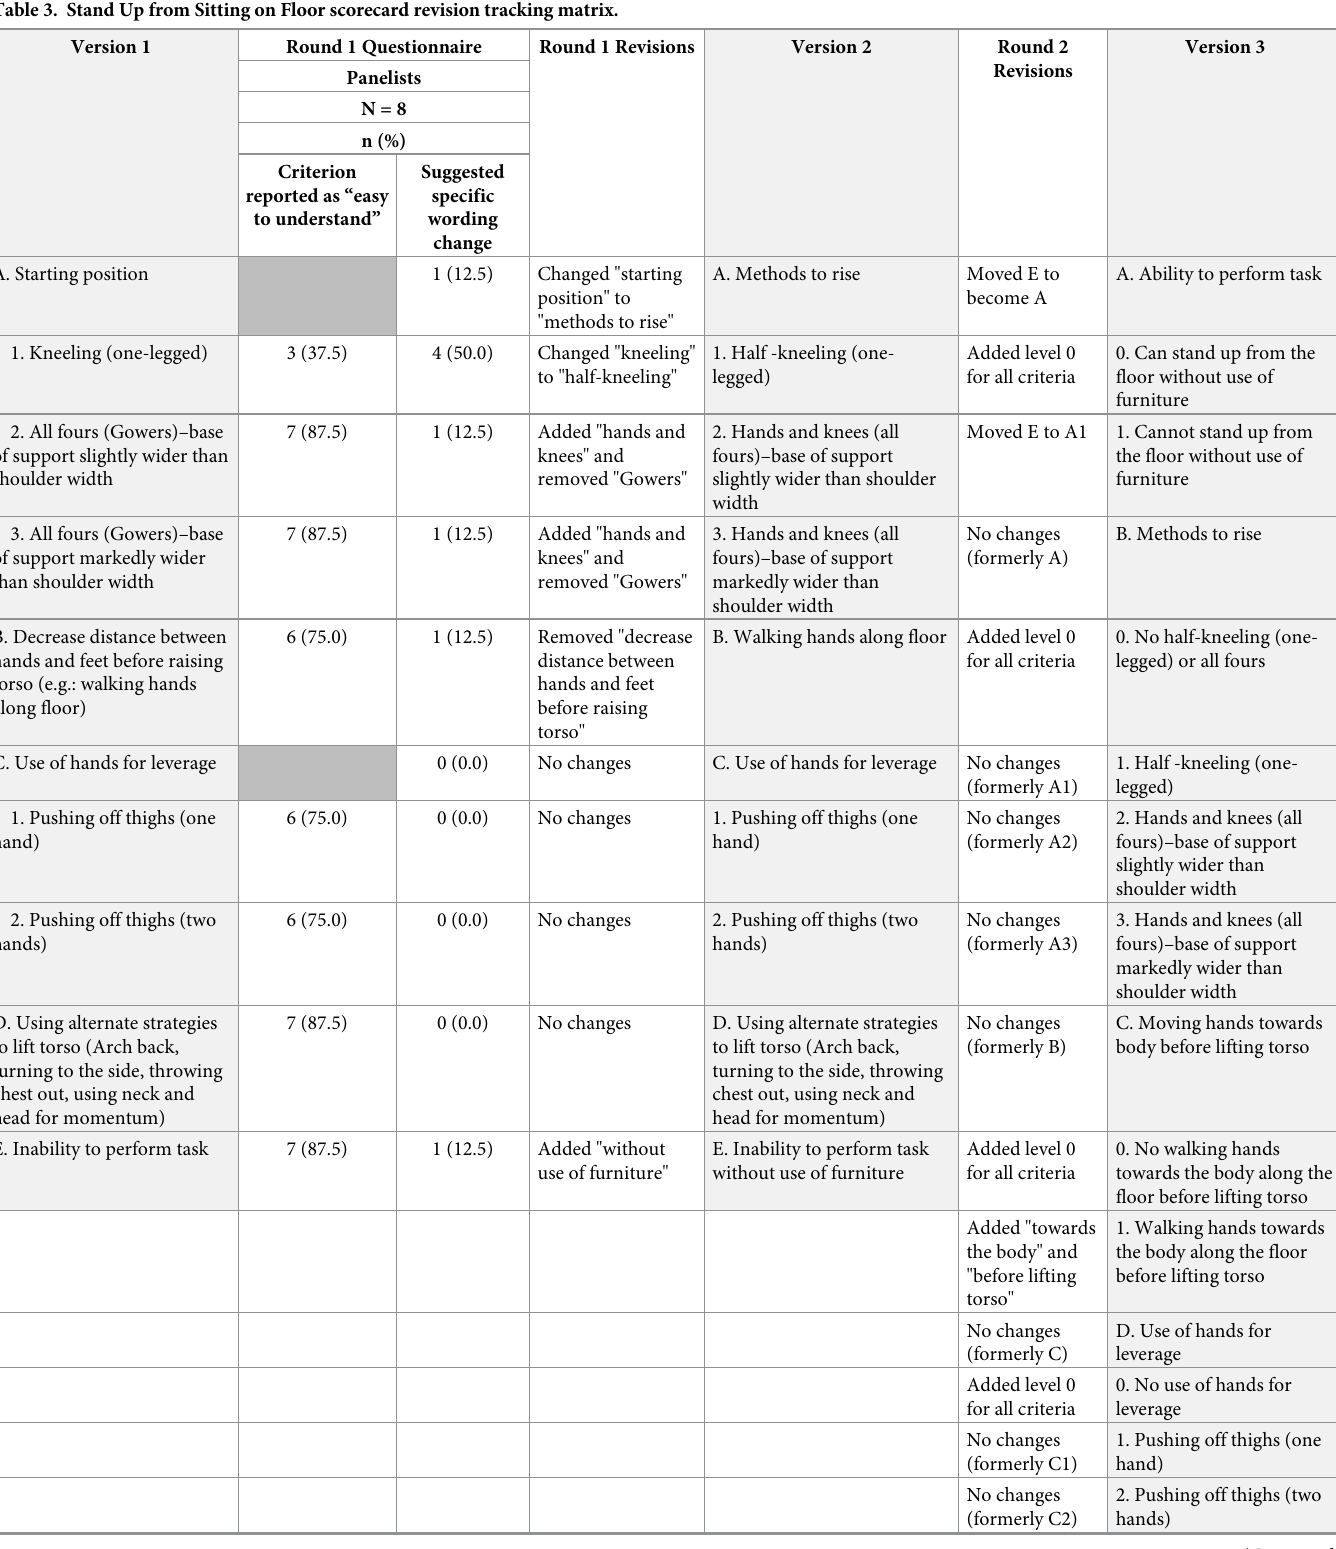
Table 3. Stand Up from Sitting on Floor scorecard revision tracking